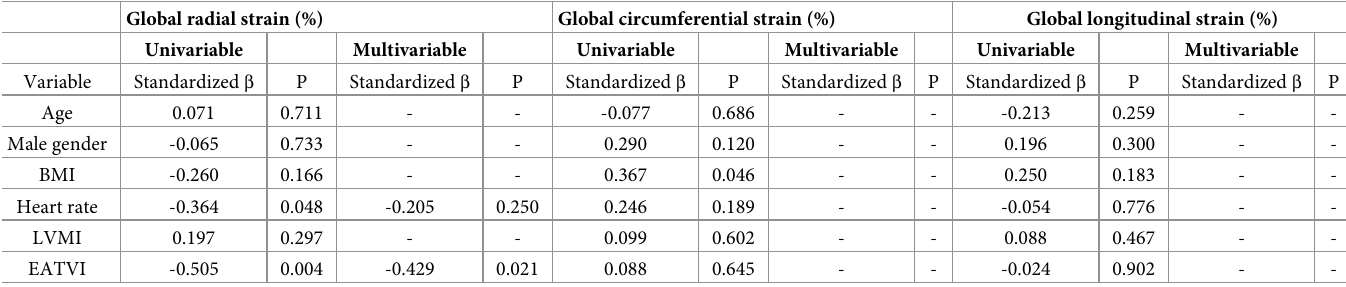
amateur marathoner group, the variables with P < 0.05, including the male gender, BMI, and Table 4. Univariable and multivariable linear regression models for LV myocardial strain amateur marathon runners (n = 30). Global radial strain (%) Univariable Multivariable Univariable Multivariable Univariable